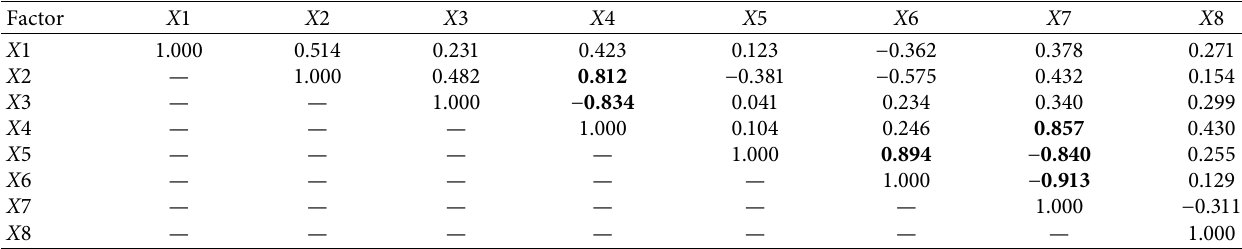
Table 3: Pearson correlation coefficient between